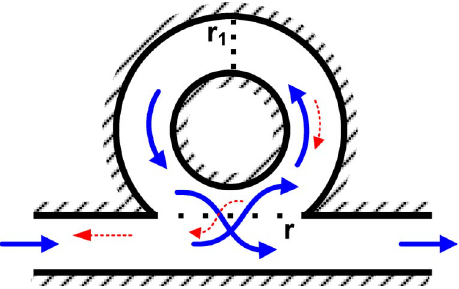
FIG. 5. (Color) An equivalent scheme to explain coupling of eigenmodes of opposite